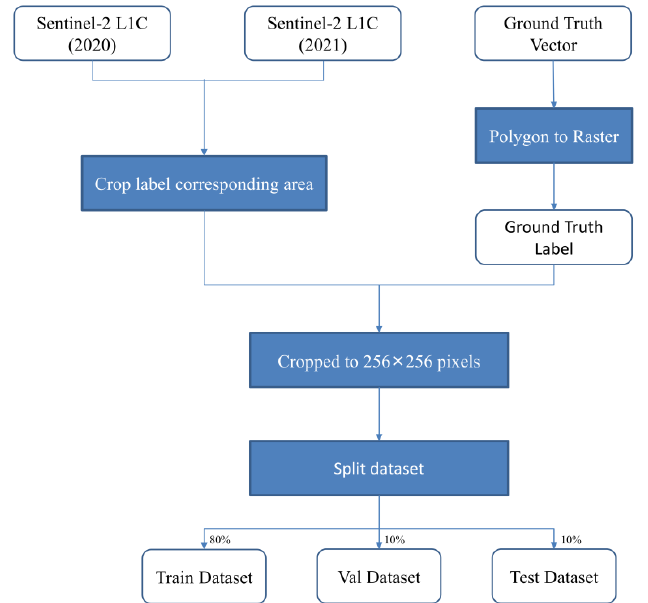
Figure 3. Flow chart of data preprocessing. The Sentinel-2 L1C images are from ESA and down- loaded through the GEE platform. The specific locations where forest change labels were collected were Changsha, Zhuzhou, Xiangtan, and Huaihua in Hunan